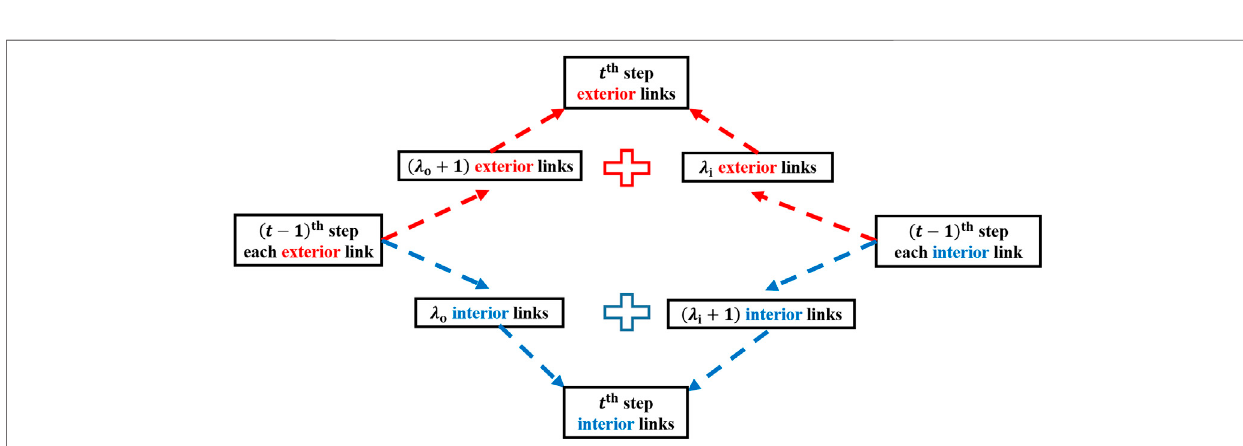
FIGURE 9 | The generation of each interior and exterior link from the ( t − 1 ) th to the t th iterative step.